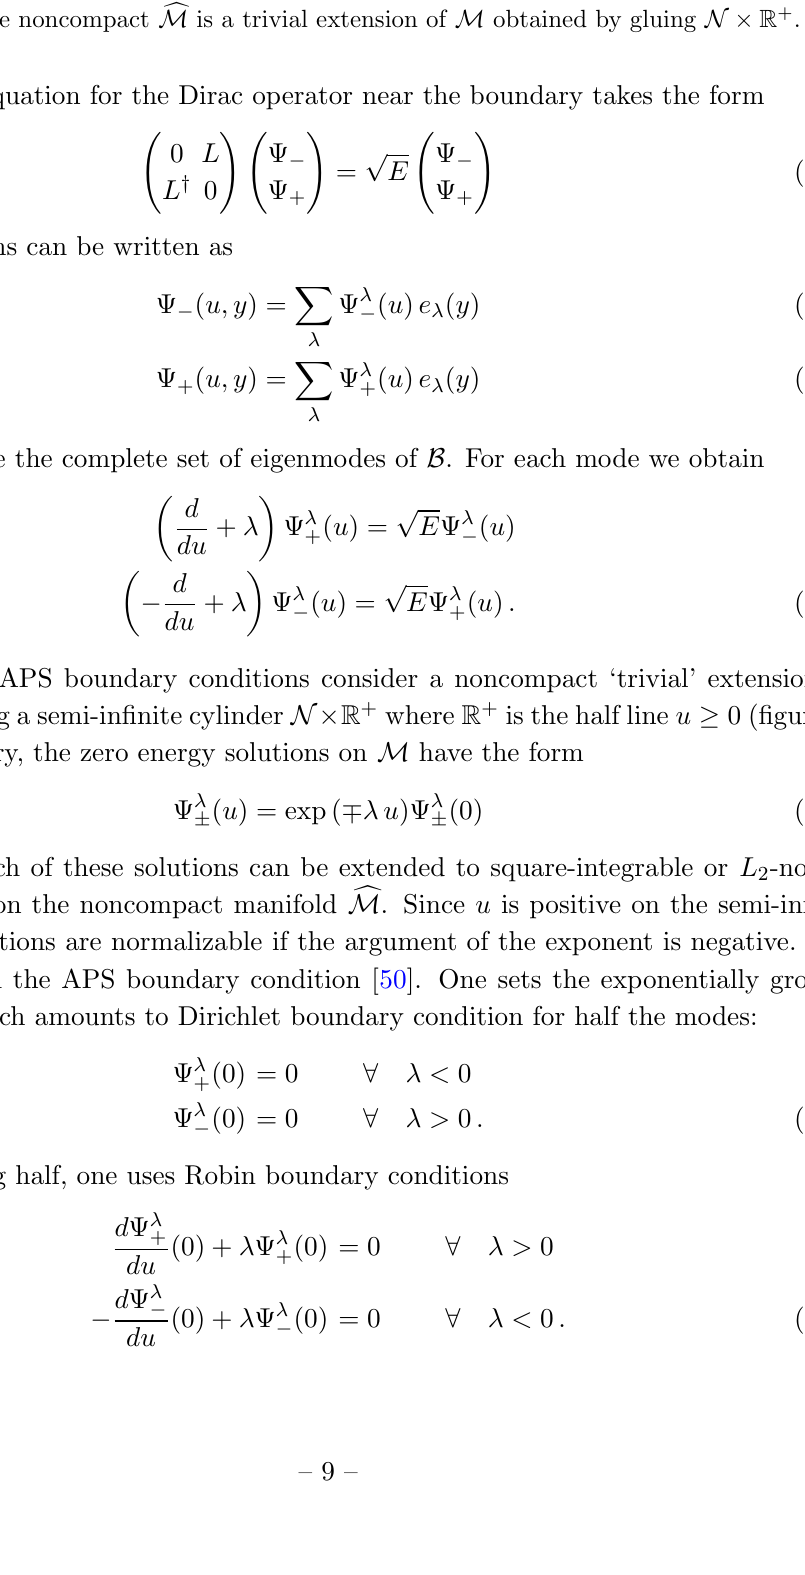
Figure 2 . The noncompact c M is a trivial extension of M obtained by gluing N (cid:2) R +